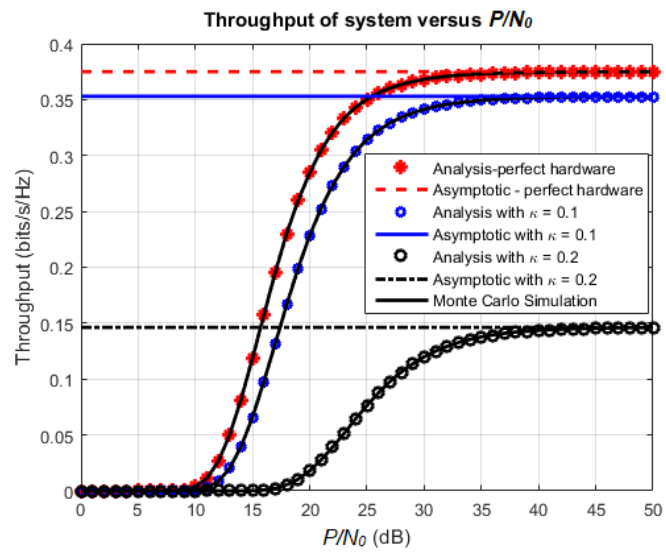
Figure 4. Achievable throughput versus P / N 0 .